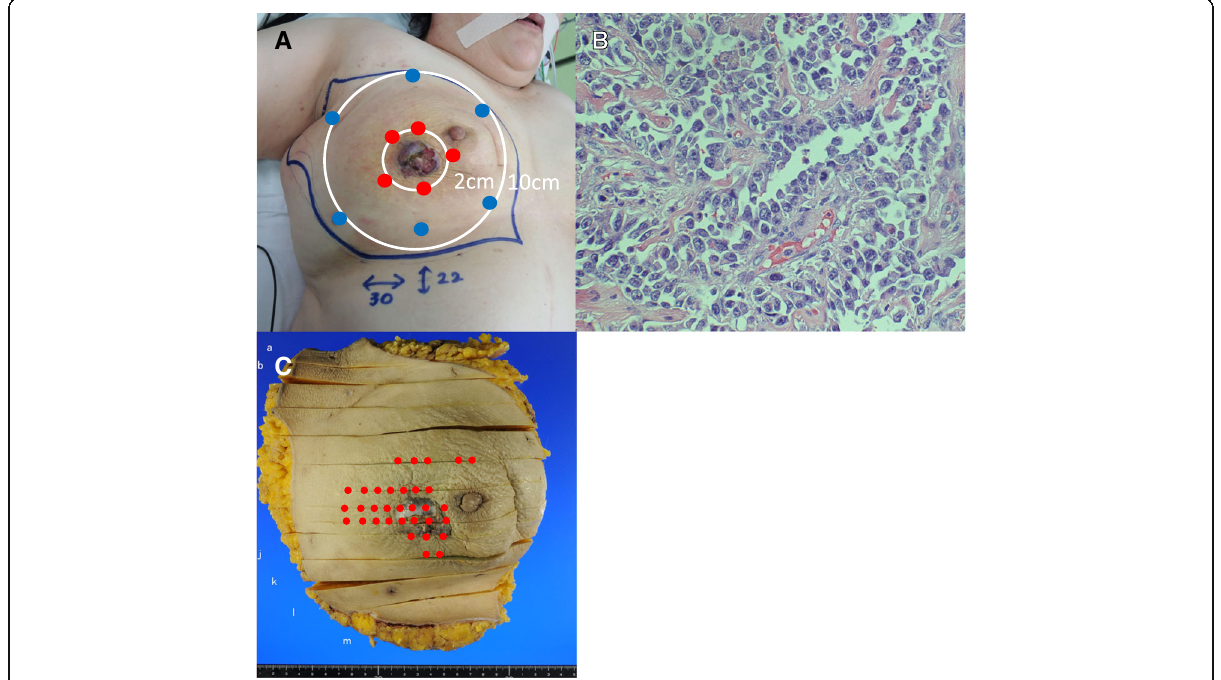
Fig. 2 Macroscopic and pathological findings (case 1). a Mapping biopsy was performed at 2 cm and 10 cm from the nodule. Red dots indicate positivity for tumor cells, and blue dots indicate negativity. b Pathological image of the resected specimen. It was diagnosed as angiosarcoma (hematoxylin-eosin [H.E.] staining: × 400). c Red dots indicate where tumor cells were observed. Tumor invasion was observed in a wider area outside the